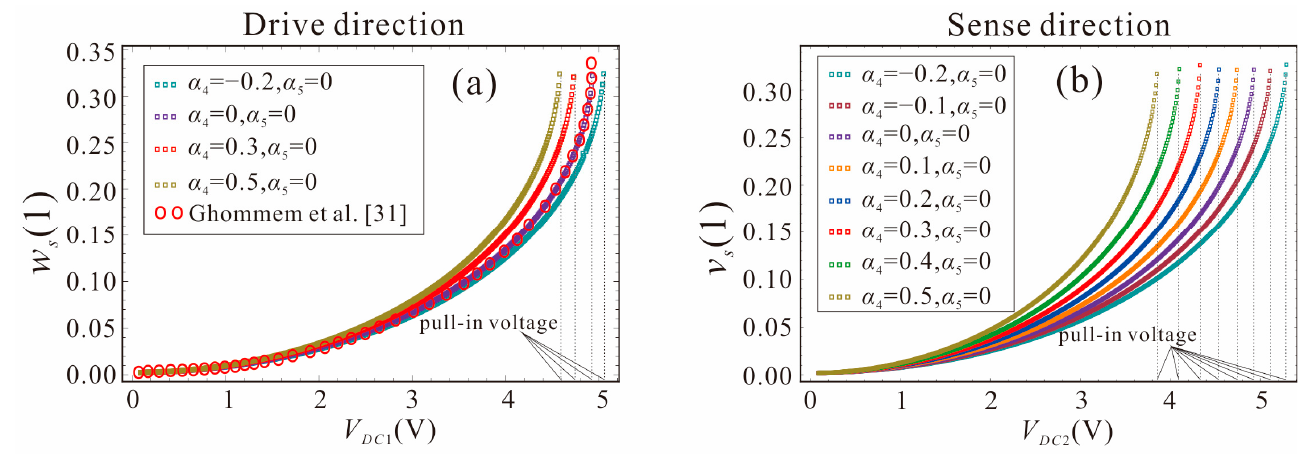
Figure 5. Variation curve of maximum displacement at the end of micro-gyroscope with DC voltage: ( a ) Drive direction, ( b ) Sense